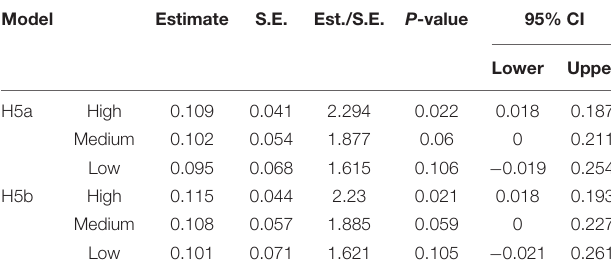
TABLE 5 | Results of moderated mediation analysis for